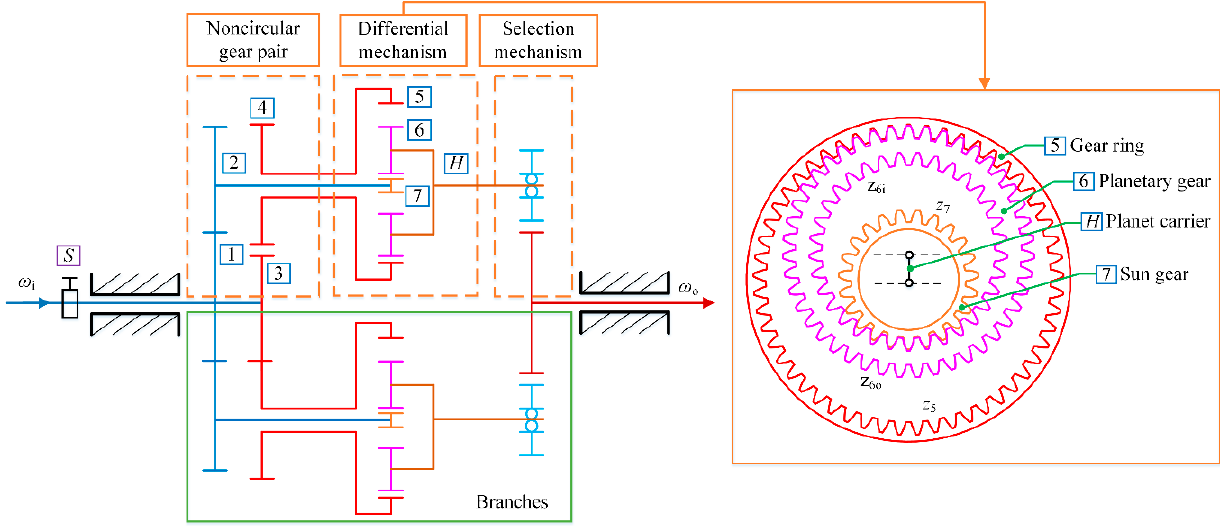
Figure 4. Transmission principle of class B.